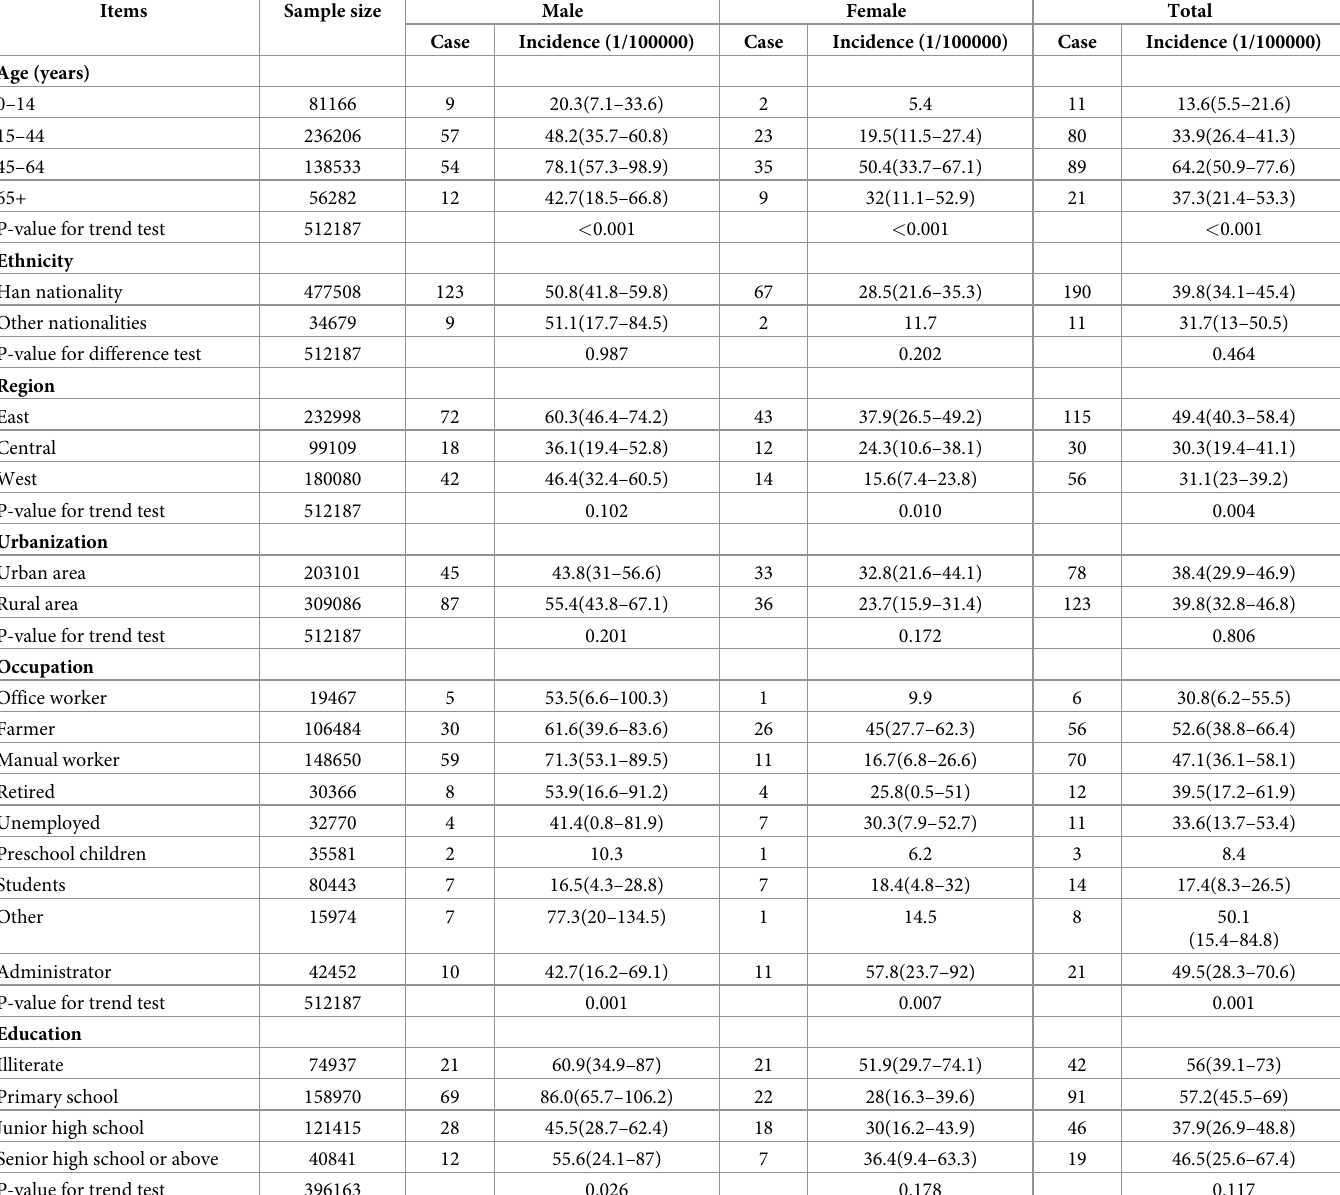
Table 1. National incidence of foot fractures among Chinese population by demographic, socio-economic and geographic factors in